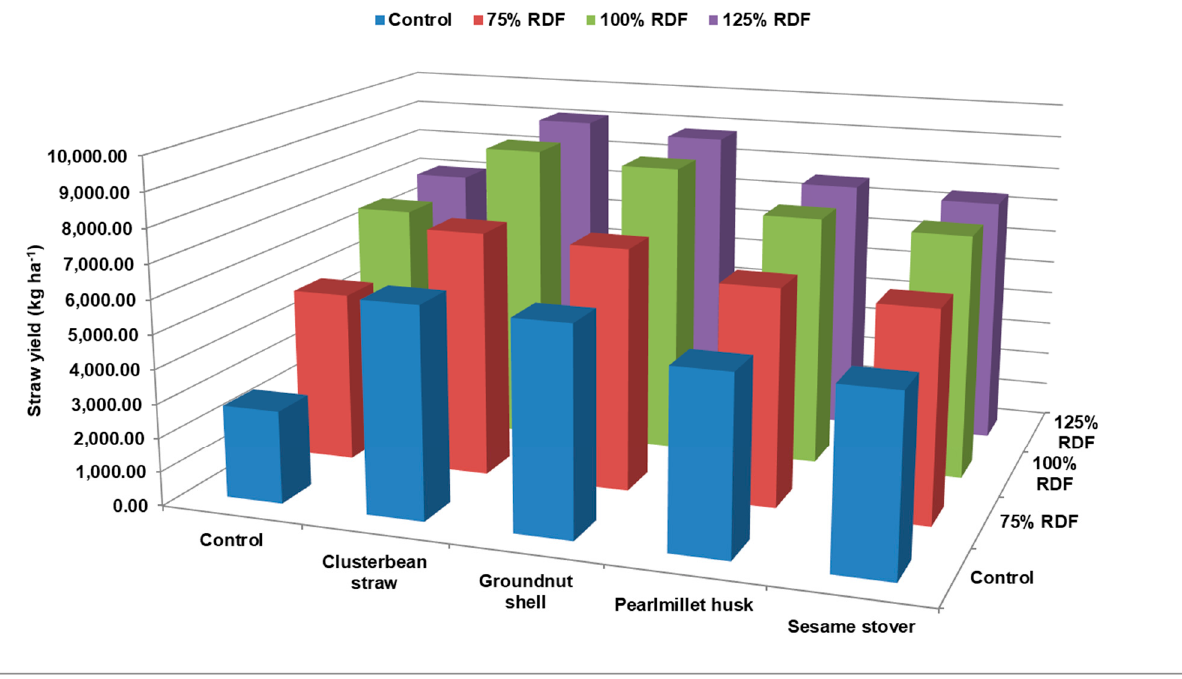
Figure 6. Effect of crop residues and fertilization on wheat yields (kg ha − 1 ) (grain and straw). In this figure, the values followed by different lowercase letters indicate no significant difference ( p > 0.05) by Duncan’s multiple range test (DMRT). 4. Discussion 4.1. Soil Microbial Biomass The microbial biomass denotes the living component of soil organic matter but ex- cludes micro-fauna and plant roots. The soil microbial biomass, which represents about 1–5% of total soil organic carbon, can provide an effective early warning of the improve- ment or deterioration of soil quality as a result of different management practices [5,63]. Our study found that the microbial biomass C, N, and P were increased significantly due to the addition of crop residues and inorganic fertilizers. When a carbon substrate was